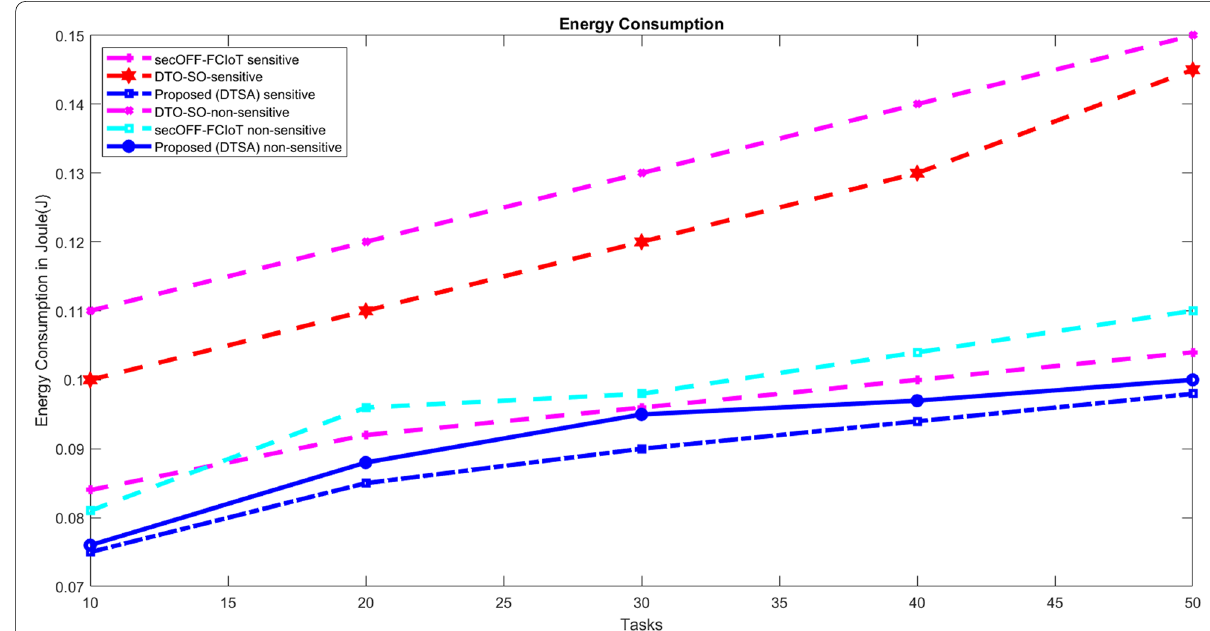
energy consumption. We also proposed an enhanced hybrid GA-PSO for device selection, while CPD based attribute reduction method is applied to downsize the